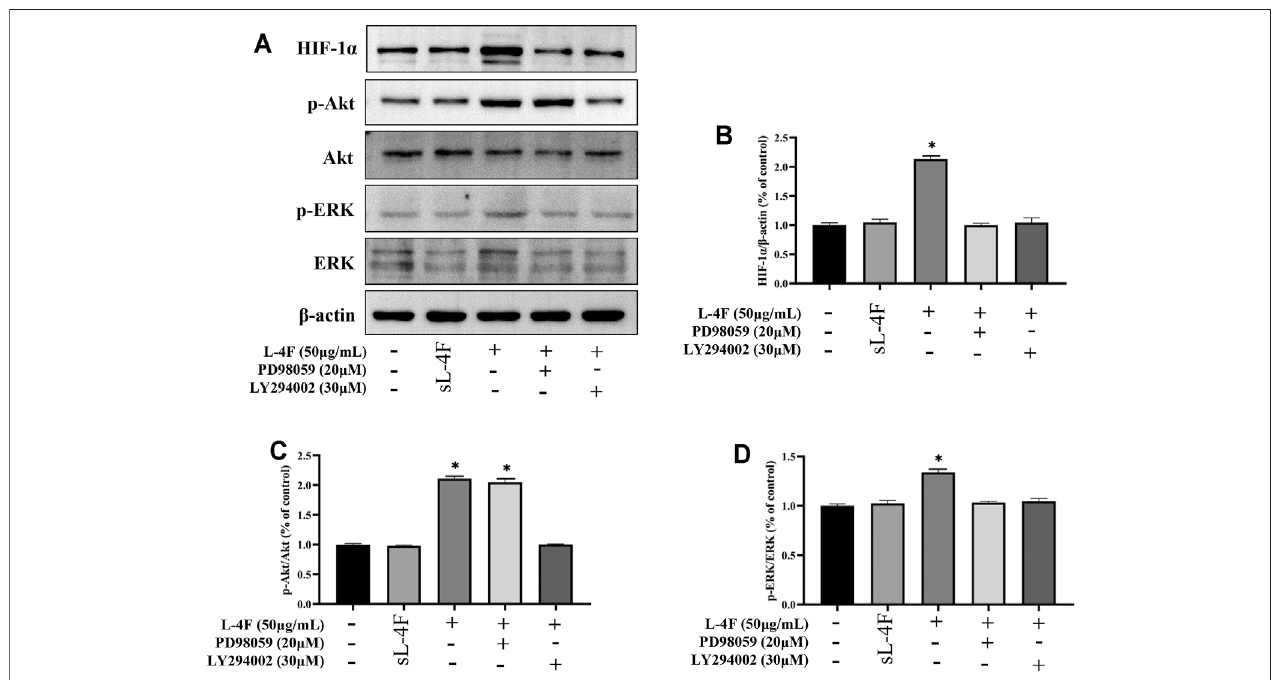
FIGURE 7 | (A) Representative Western blot images. Pretreatment of LY294002 and PD98059 suppresses protein levels of HIF-1 α (B) , p-Akt (C) , and p-ERK (D) inducedbyL-4FinHUVECs.Cellswerepretreatedwithandwithoutrelevantspeci fi cinhibitorsfor2 hpriortothetreatmentwithL-4ForsL-4Fat50 μ g/mlfor30 min, n (cid:1) 3, one-way ANOVA, SNK test, ** p < 0.01, compared with other groups.